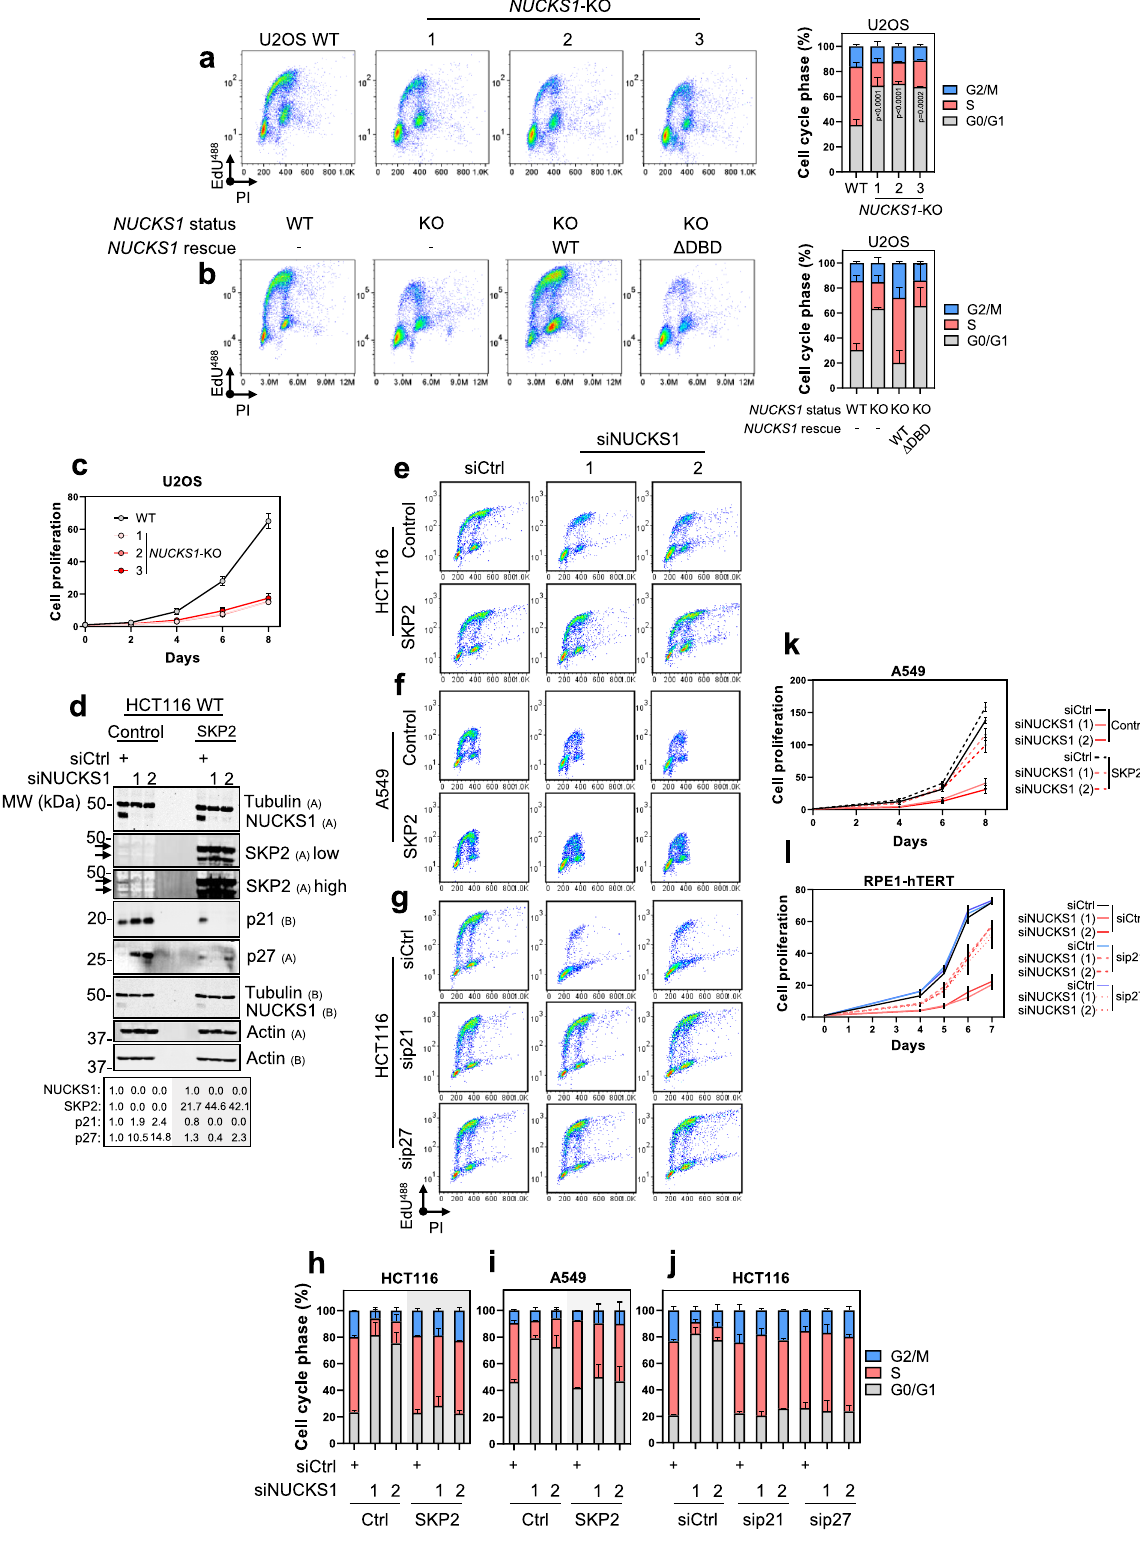
(CPT), DNA-damaging agents which induce distinct DNA lesions. Upregulation of CDKN1A mRNA, encoding p21, was used as a control for p53 activation. We found that NUCKS1 and SKP2 transcripts are substantially reduced in response to all tested DNA-damaging agents (Fig. 5d). Consistent with Western blotting data, this is largely dependent on p53 (Fig. 5e –